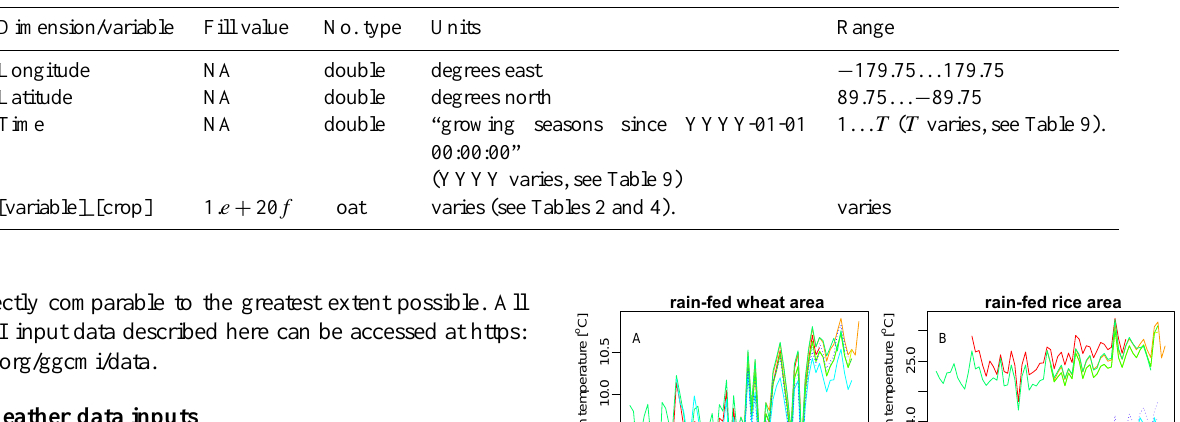
Table 7. NetCDF file dimension, variable, and attribute info.